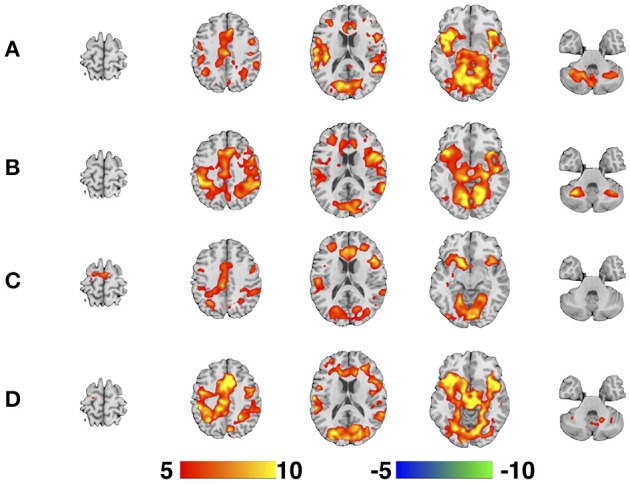
One-sample t-test maps for each of the four EPI sequences. (A) SHORT, TR = 700 ms; (B) AVG2, TReffective = 1400 ms; (C) AVG4, TReffective = 2800 ms; (D) REF, TR = 1440 ms. Color bar is given in terms of T-statistic, and maps are thresholded at p < 0.05, Family-Wise Error corrected. Slices were created using Mango (http://ric.uthscsa.edu/mango/; Jack L. Lancaster and Michael J. Martinez).